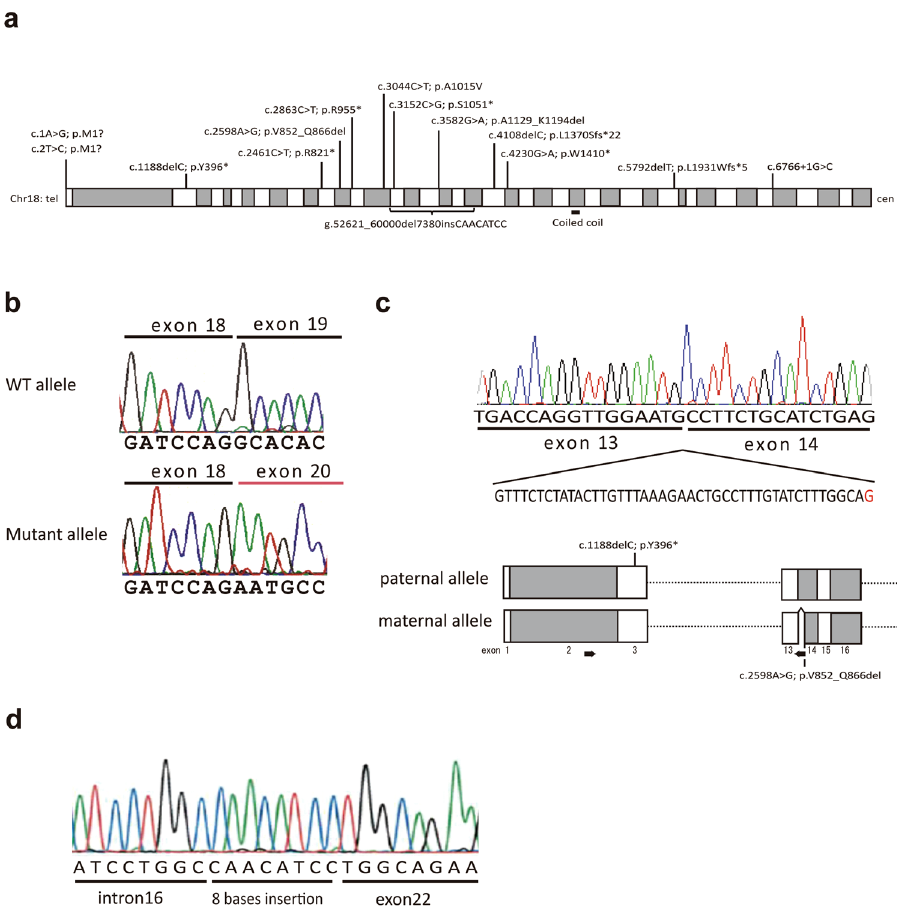
Figure 1. EPG5 mutations identified in nine Vici syndrome patients. ( a ) Schematic of the EPG5 gene located in 18q12.3 illustrating mutation locations. White and gray rectangles represent exons (1 through 44). ( b ) Aberrant splicing caused by the synonymous mutation in patient 3.1 (c.3582 G > A) identified the removal of exon 19. WT, wild type. ( c ) Aberrant splicing caused by the synonymous mutation in patient 5.1 (c.2598 A > G). Above ; RT-PCR identified a 45-bp in-frame deletion in exon 14 induced by a cryptic splicing acceptor site created by 2598 A > G (shown in red). The mother of patient 5.1 also had this mutation. Below ; Confirmation of compound heterozygosity. The paternal allele was amplified by PCR using a reverse primer that binds to the region deleted in the maternal allele. The paternal PCR product contained the c.1188delC mutation, indicating that patient 5.1 was a compound heterozygote. The location of the mutation in patient 5.1 is shown. The arrows represent PCR primers. White and gray rectangles represent exons. ( d ) A multi-exon deletion identified in patient 7.1. Cloning and sequencing of the genomic breakpoint and flanking regions revealed an 8-bp insertion of unknown origin at the